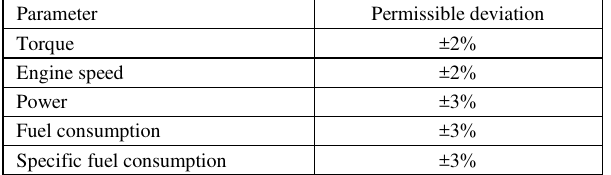
Table 1. Acceptable deviations of the measured engine parameters acc. [17]